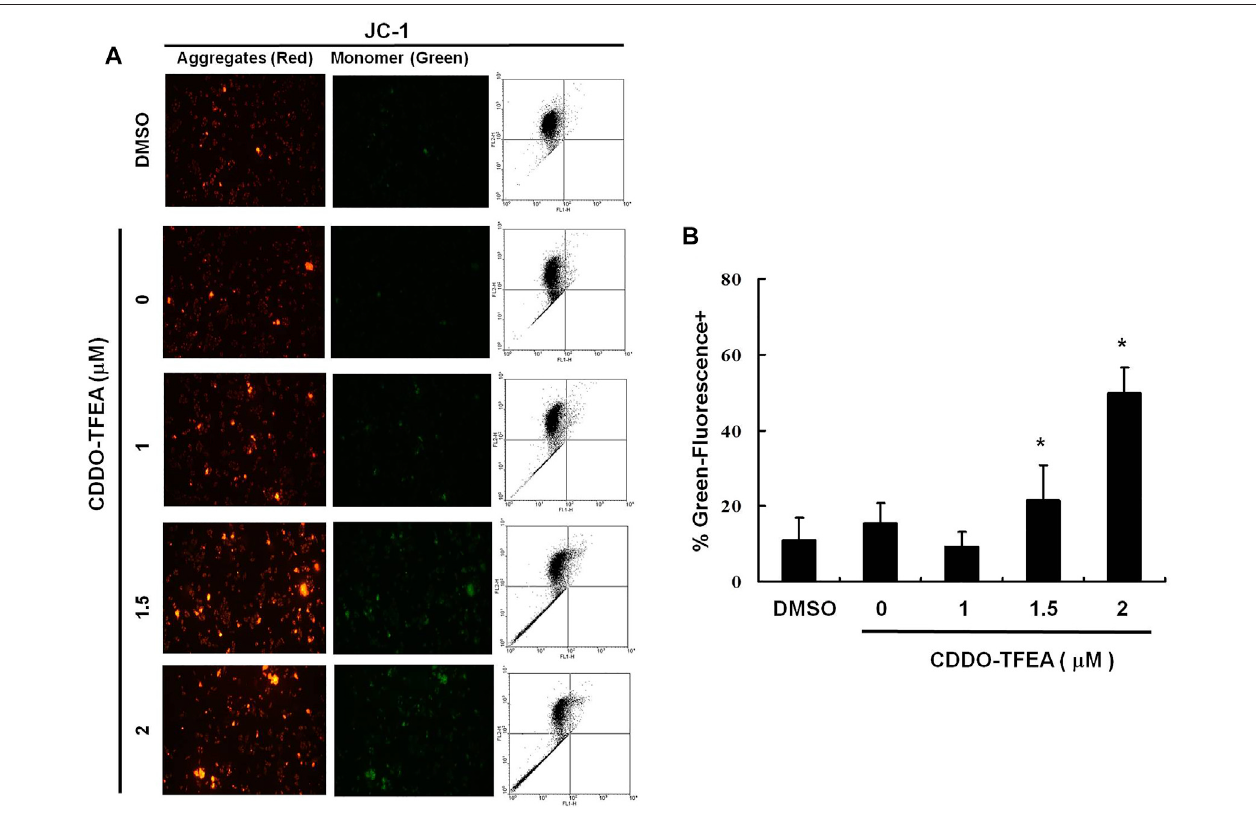
FIGURE3| ThedisruptionofmitochondrialmembranepotentialduetoCDDO-TFEAtreatment. (A) JC-1wasalso detectedbyusing fl uorescencemicroscopyand fl ow cytometry. (B) Results are expressed as percentage of the control, control being 100%. All data are reported as the mean ( ± SEM) based on results of at least three separate experiments. Statistical analysis was performed using the t test, with differences between the treatment and control groups (0 M CDDO-TFEA) considered signi fi cant at p < 0.05, delineated by *.